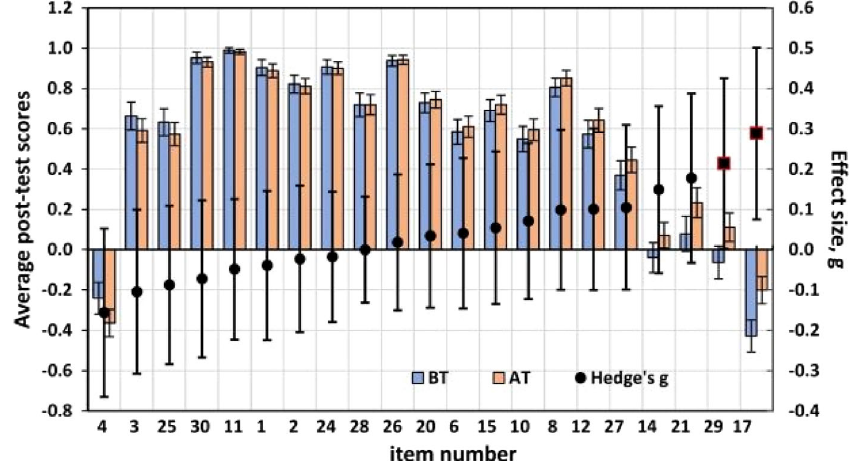
FIG. 4. Women ’ s average post-test scores in the BT (blue) and AT (orange) courses on E-CLASS items (bar graph) that are not related to the AT course learning goals. Effect sizes, Hedge ’ s g and the corresponding 95% confidence intervals, are plotted as symbols for each of the items. Items with significant differences between BT and AT post-test scores for women are denoted by